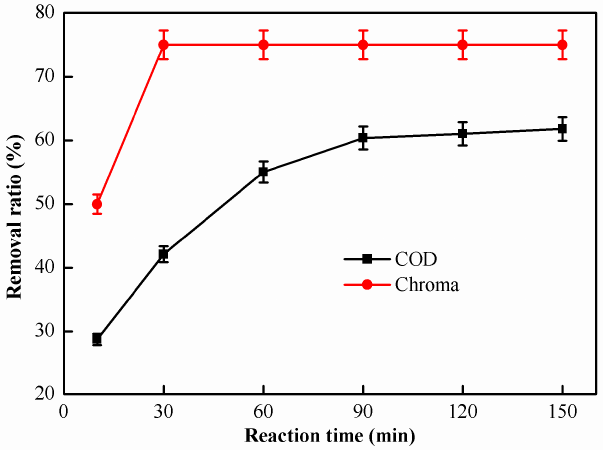
Figure 10. Effect of reaction time on catalytic oxidation performance.